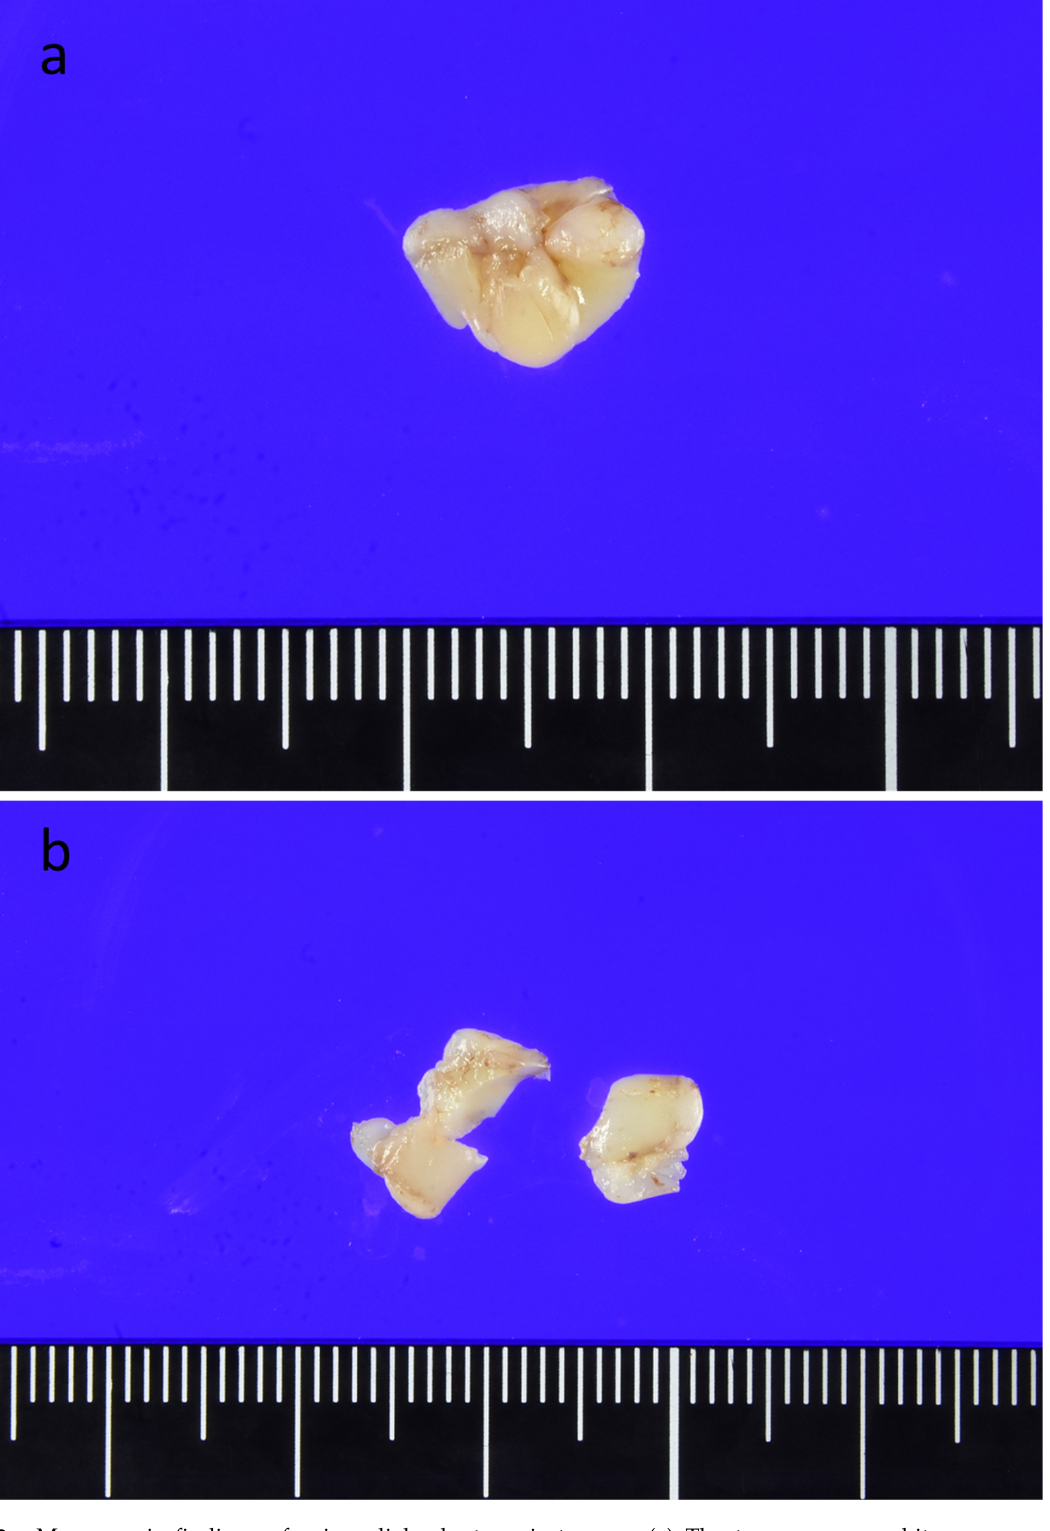
Figure 2. Macroscopic findings of primordial odontogenic tumor. ( a ) The tumor was a white mass measuring 10 × 7 × 3.5 mm. ( b ) The cut surface was a solid, not cystic lesion.